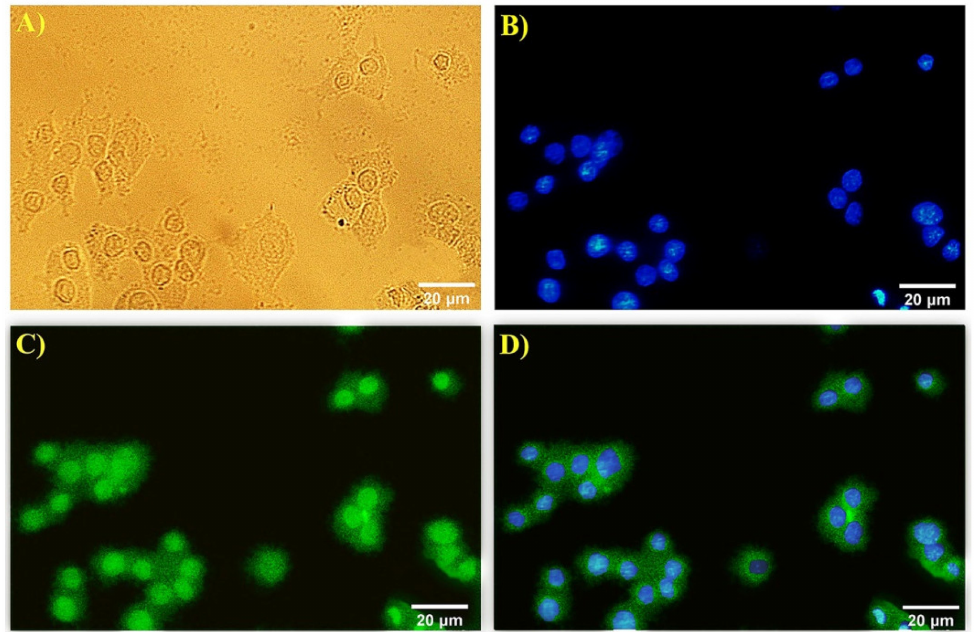
Figure 3. Immunofluorescence images of differentiated PC12 cells after 5 days of treatment with curcumin (20 µ M). ( A ) Control, ( B ) DAPI staining, ( C ) β 3-tubulin staining, and ( D ) the merge of ( B ) and ( C ). β 3-tubulin fluorescently stained in green, and nuclei in